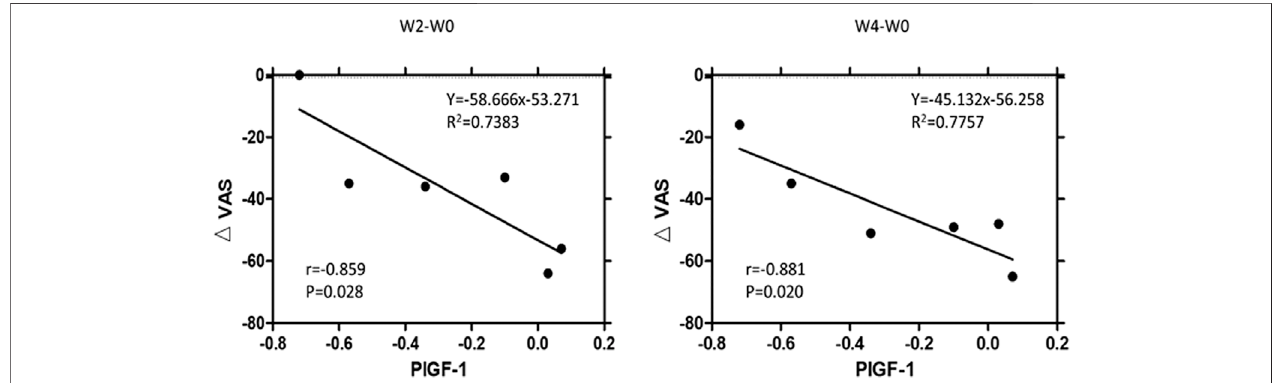
FIGURE10| Correlationbetweenthesigni fi cantdecrease ofurinaryconcentrationofplacentalgrowth factor-1( Δ PIGF-1)and signi fi cantdecrease ofpainintensity ( Δ VAS; VAS (cid:1) visual analog scale) at 2-week and 4-week follow-up. R2 (cid:1) multivariate coef fi cient of determination.